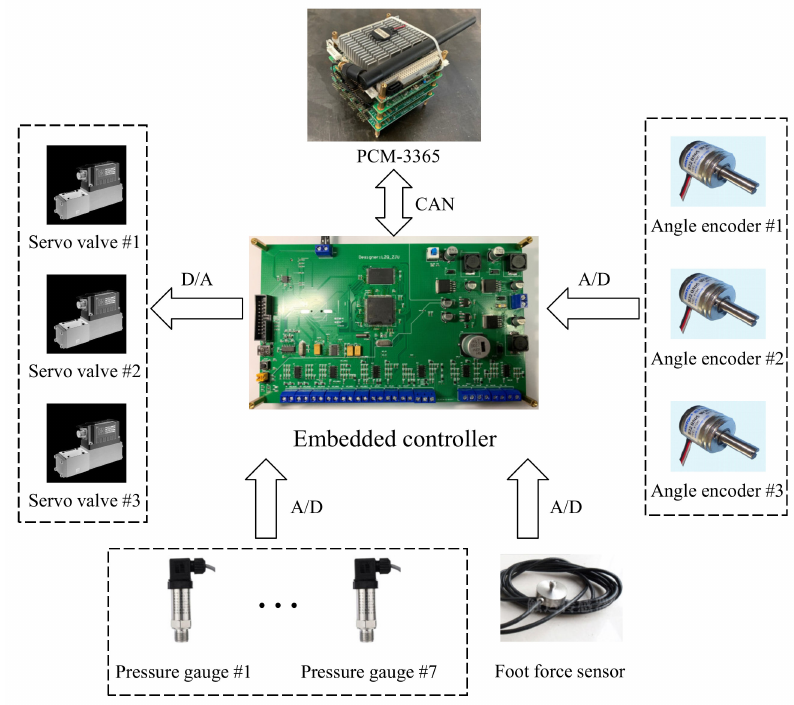
Figure 5. Electrical connections of the embedded